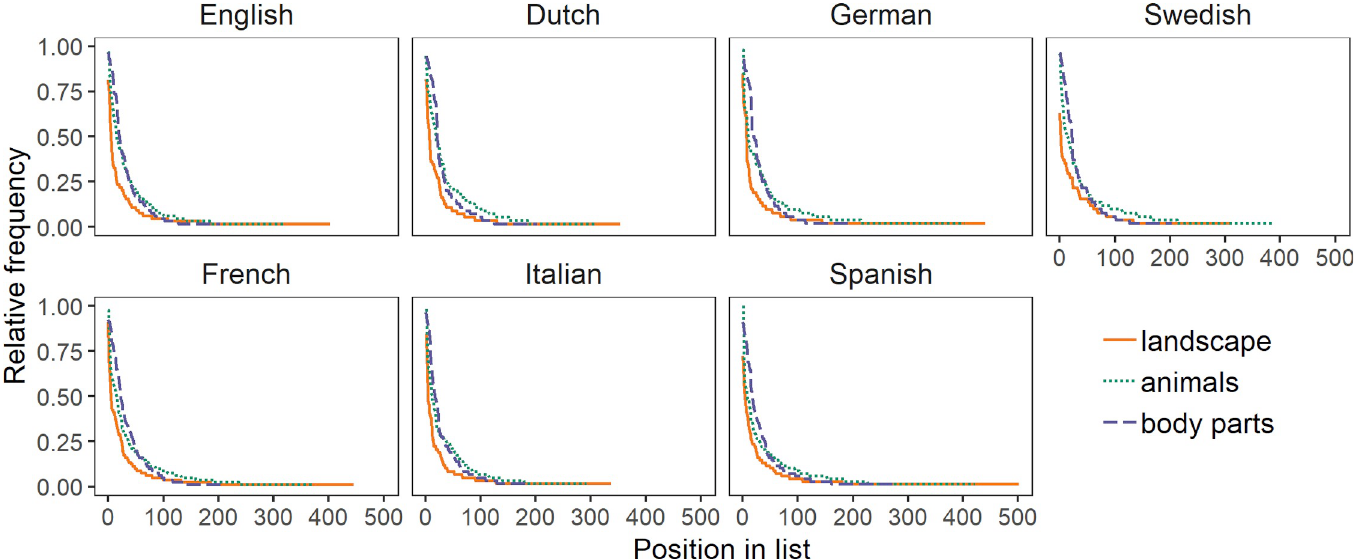
Fig 2. Frequency distributions of exemplars listed for “animals”, “body parts” and “landscape” in seven languages. The x-axis represents an exemplar in an ordered list from most to least frequent. The y-axis represents frequency relative to the number of participants. “Landscape” had fewer high-frequency exemplars than the other domains in all languages, and also more unique exemplars in all but one